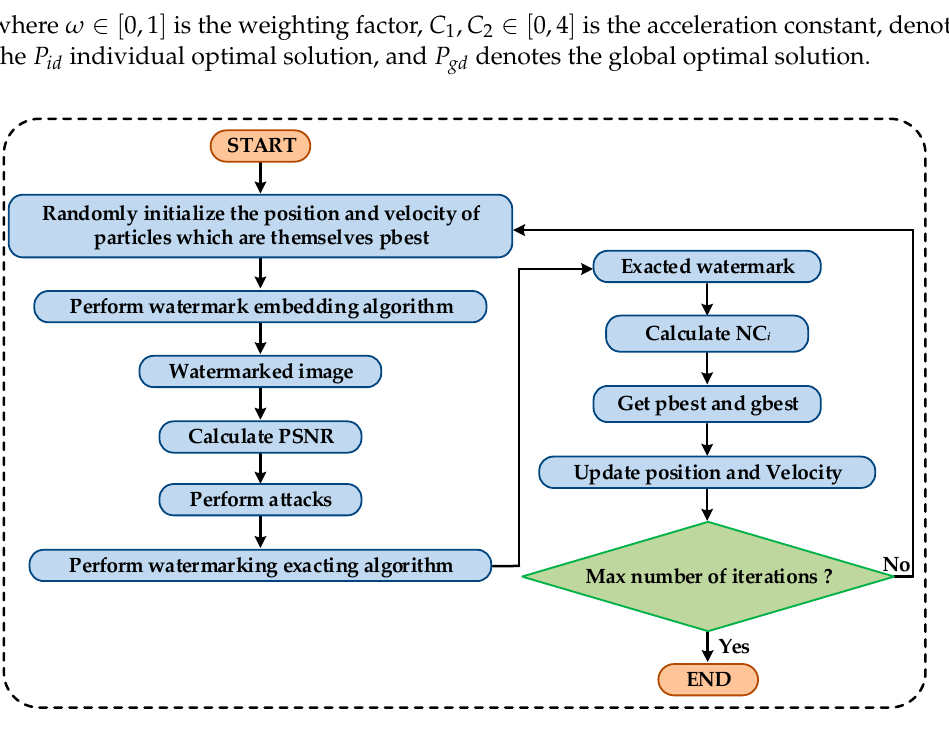
Figure 4. The flow chart of PSO.